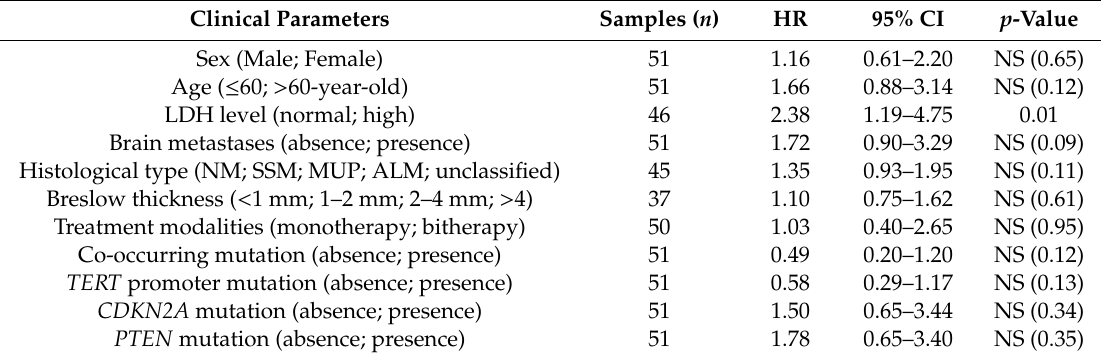
Table 2. Univariate analysis of clinical parameters and sample mutational status with regard to progression-free survival (PFS) in BRAF V600 patients.